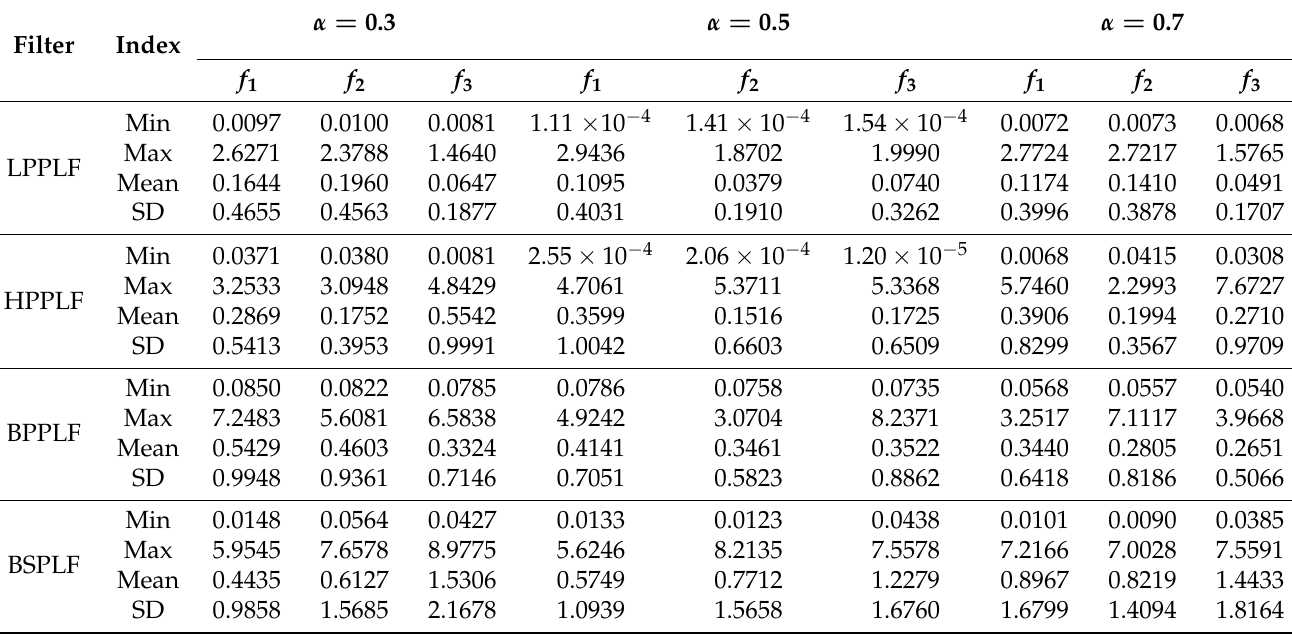
Table 2. Statistical comparisons of the MARE for designed